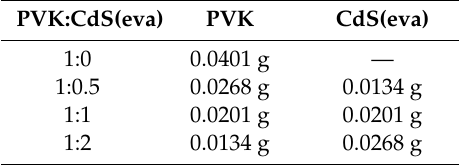
Table 2. Stoichiometry of hybrid solutions prepared with evaporated CdS nanoparticles. PVK:CdS(eva)